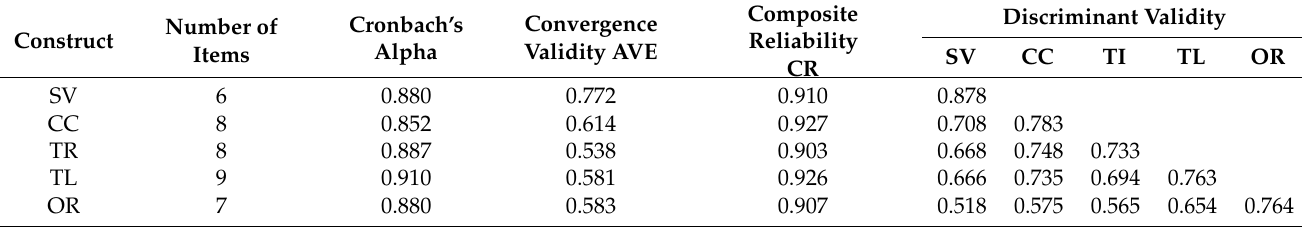
Table 1. Cronbach’s Alpha, convergence validity, composite reliability, and discriminant validity for the measurement